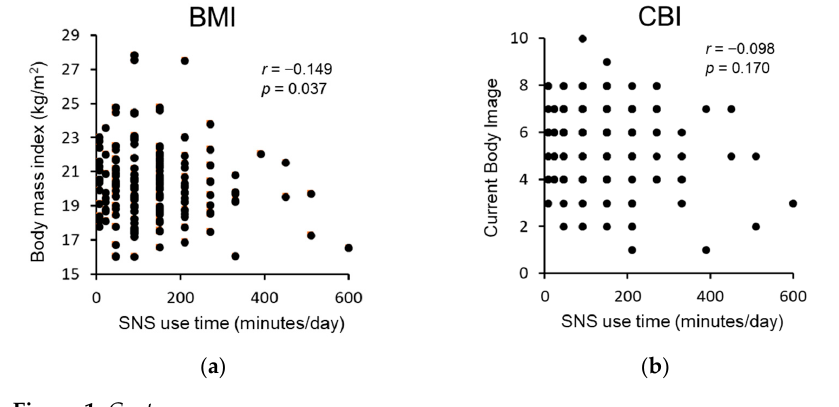
(d) Figure 1. Correlations between the duration of SNS use and ( a ) body mass index, ( b ) current body image, ( c ) ideal body image, and ( d ) body dissatisfaction (all n = 196). Spearman’s correlation. Body dissatisfaction was calculated as the difference between current and ideal body image. SNS = social networking sites. Use of nutrition labels ( r = − 0.159, p = 0.026) and the frequency of consumption of milk and dairy products ( r = − 0.195, p = 0.006) were negatively correlated with the duration of SNS use. Frequency of consumption of fruit, fish, and alcohol was not significantly cor- related with the duration of SNS use. 3.3. Characteristics in the Long and Short Time Groups of SNS Use 3.3.1. Daily SNS Use Table 1 shows the daily SNS use, body shape, body image, Objectified Body Con- sciousness, and subjective feelings of the long and short groups. Compared to the short group, the long group accessed SNS more frequently ( p < 0.001), took more selfies ( p = 0.001), and posted more of them ( p = 0.001) per day. There were no differences in the fre- quency of viewing others’ photos of themselves (Table 1).